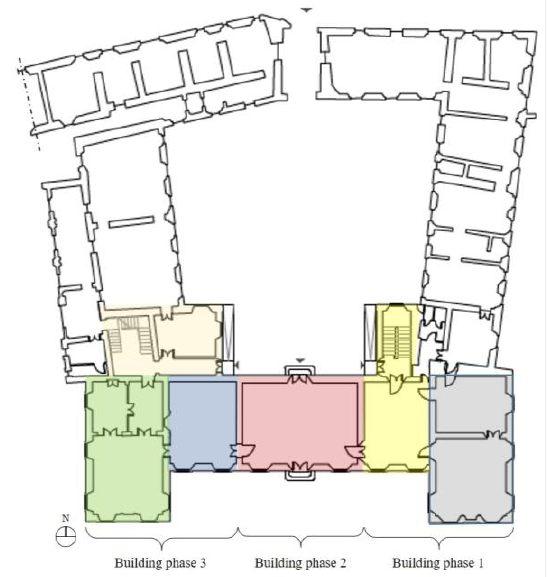
Figure 5. Plan of Trotti Palace complex with a layout of the main constructive phases of the principal 17 th century building.